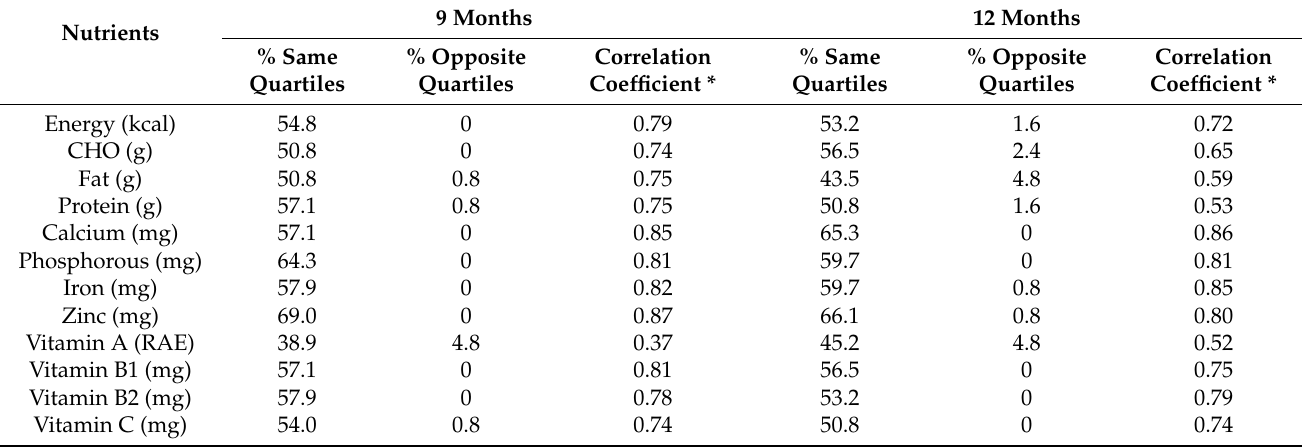
Table 4. Bland–Altman analyses.